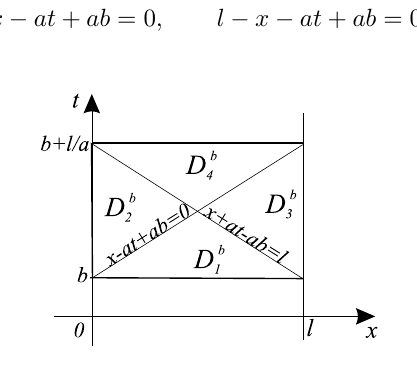
Figure 2. Division of domain Ω b into four